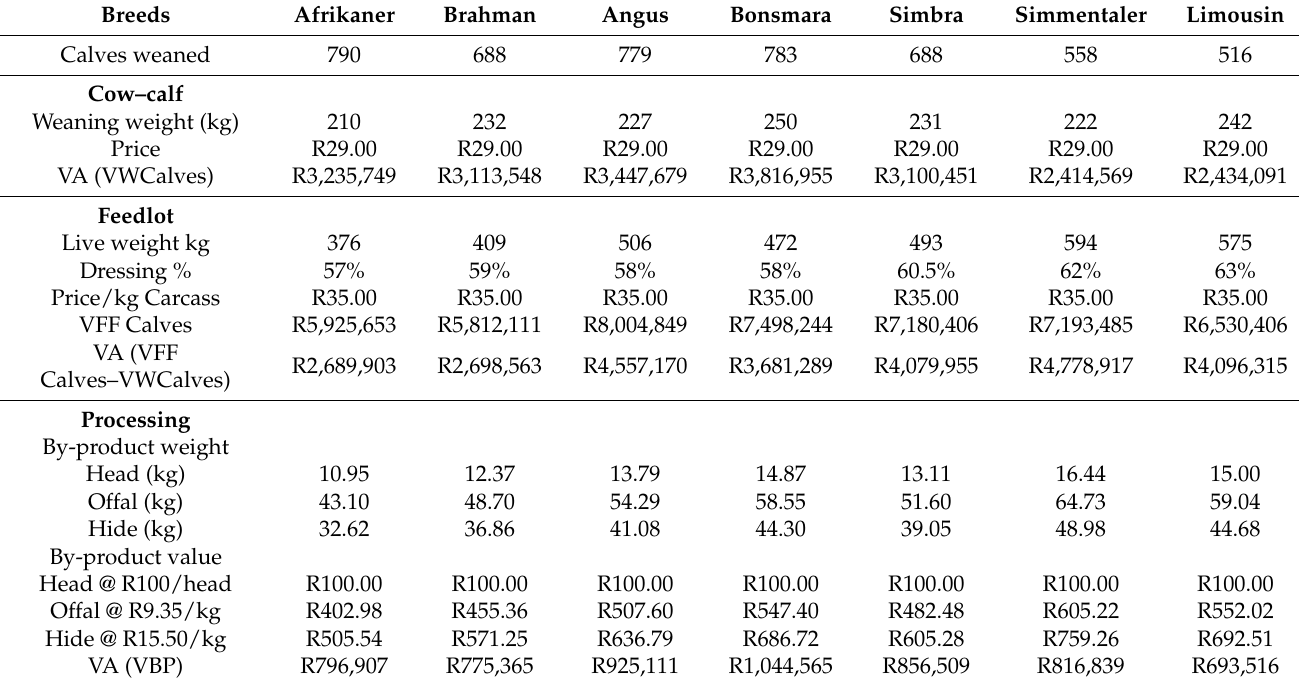
Table 2. Value addition of the different breeds for each link in the value